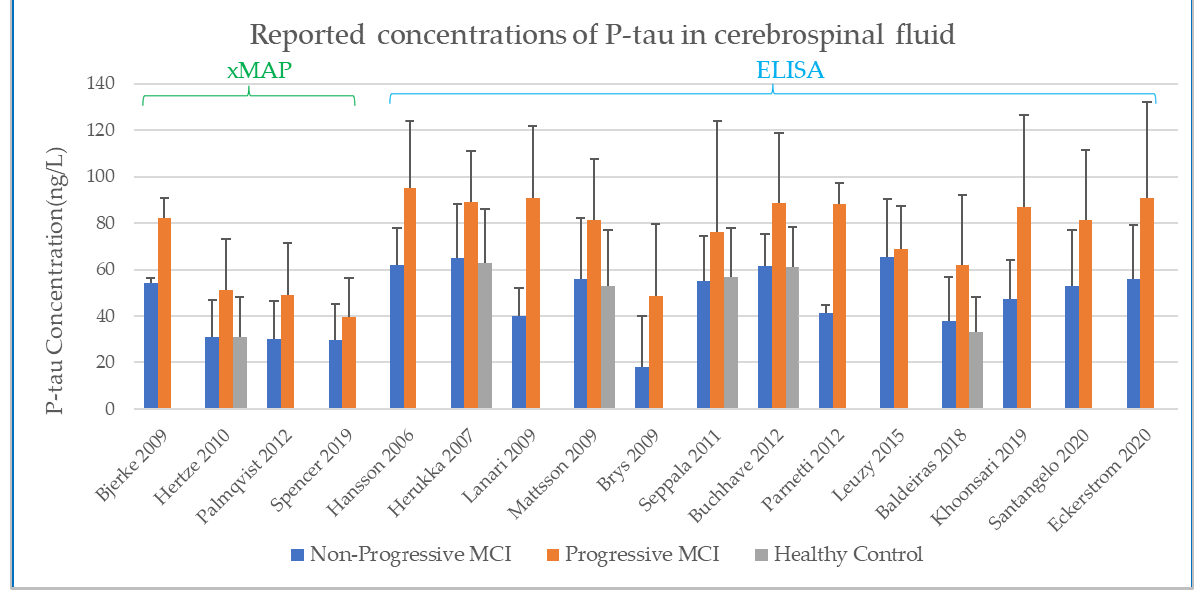
Figure 5. Concentration of P-tau in CSF at baseline, as determined by xMAP and ELISA.